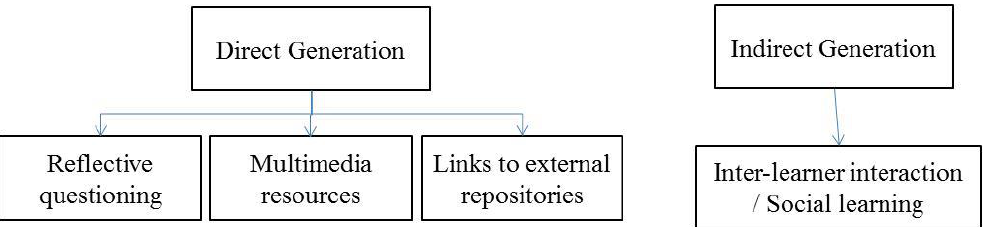
Figure 2 . MOOC pedagogical tools that generate personal